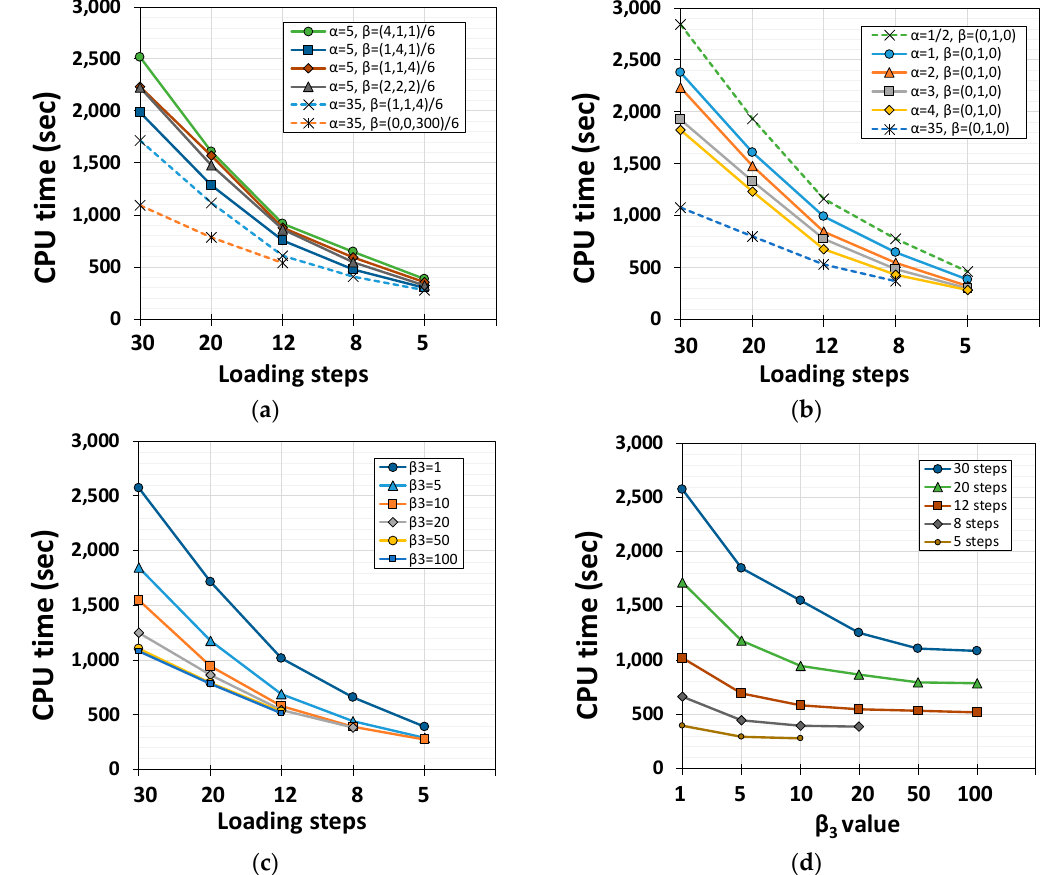
Figure 13. Computational efficiency of Quadratic SMPT1 using the standard α -method and penalty α -method : the influences of different ( a ) weights, ( b ) values, ( c ) which is the third component of , and ( d ) time intervals.